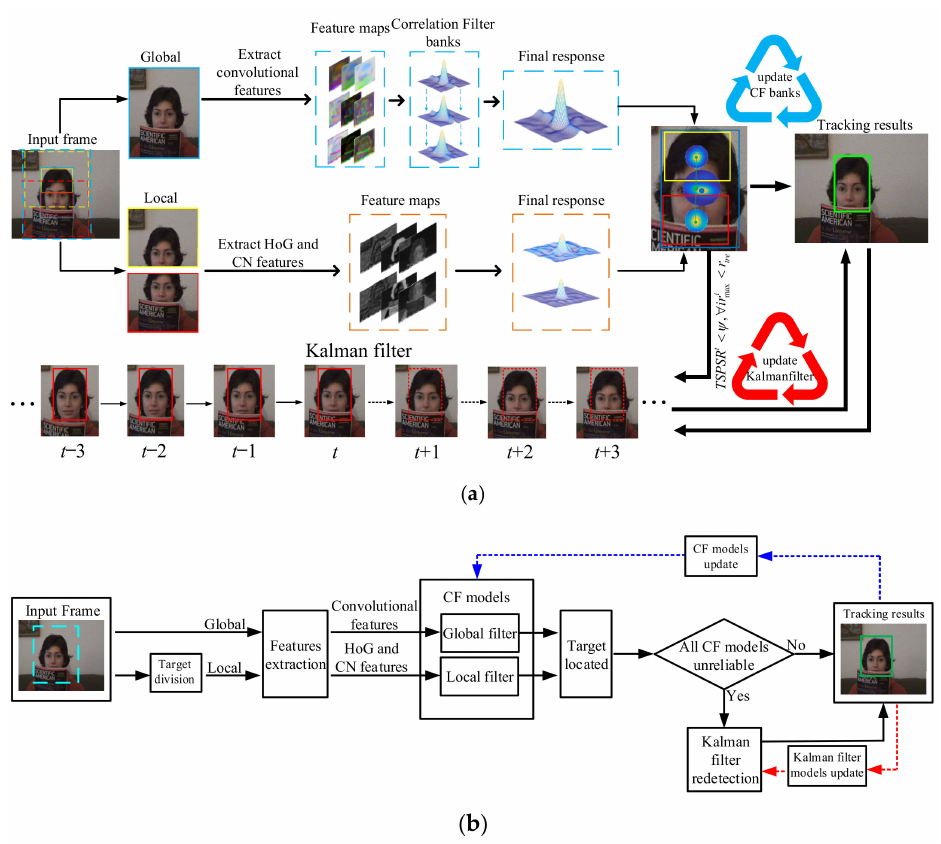
Figure 2. System overview of our proposed tracking algorithm. We divide the target according to its aspect ratio, and then use a combination of local filters and global filters to achieve accurate object tracking. When the robustness scores of the CF are lower than a certain threshold, we enable the KFR mechanism to recapture the target. ( a ) Visualization of data flow in our proposed tracking algorithm. ( b ) The functional components and their connections in our proposed tracking algorithm. The blue dashed line indicates the collaborative update strategy of the correlation filter (CF), and the red dashed line indicates that the Kalman filter (KF) needs to be updated after Kalman filter redetection (KFR) is turned on.